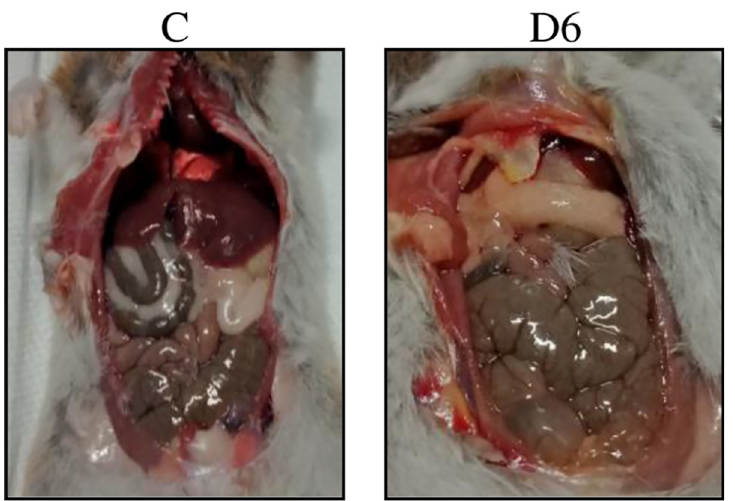
Fig 2. Gross finding in dissected areas. The yellowish discolouration was observed on adipose tissue on day 6 p.i. in infected hamsters. C: control; D6: day 6 p.i.